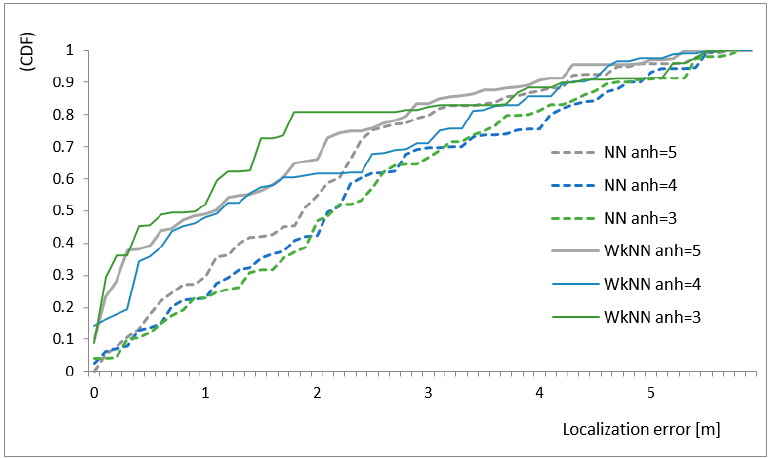
Figure 11. Comparison of the localization quality for different number of anchors for the industrial laboratory.